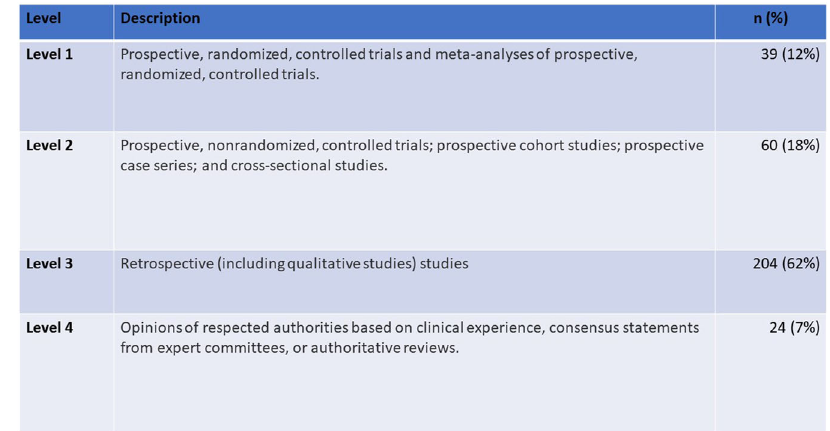
Fig. 2 Publications categorised by PDQ Levels of Evidence. Excludes four systematic reviews and one PhD thesis.